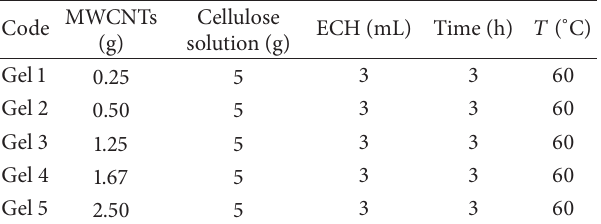
Table 1: Reaction conditions and material compositions of the various cellulose/MWCNTs hydrogels.